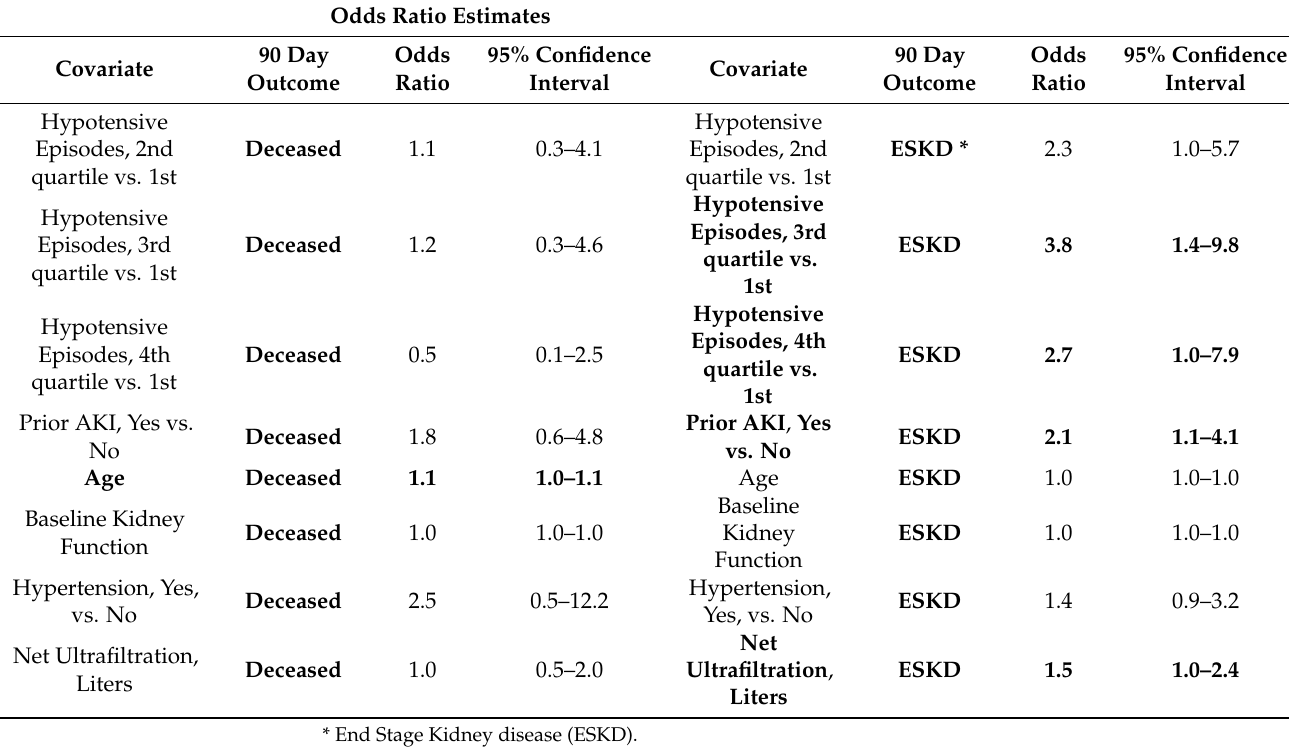
Table 2. Multinomial Logistic Regression Model Results.